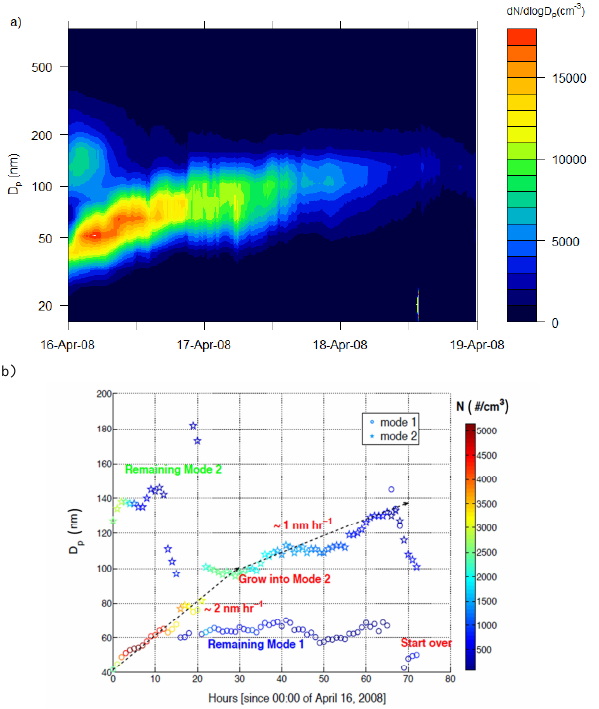
(a) size distribution as a function of time, (b) growth analysis of dominant size modes.